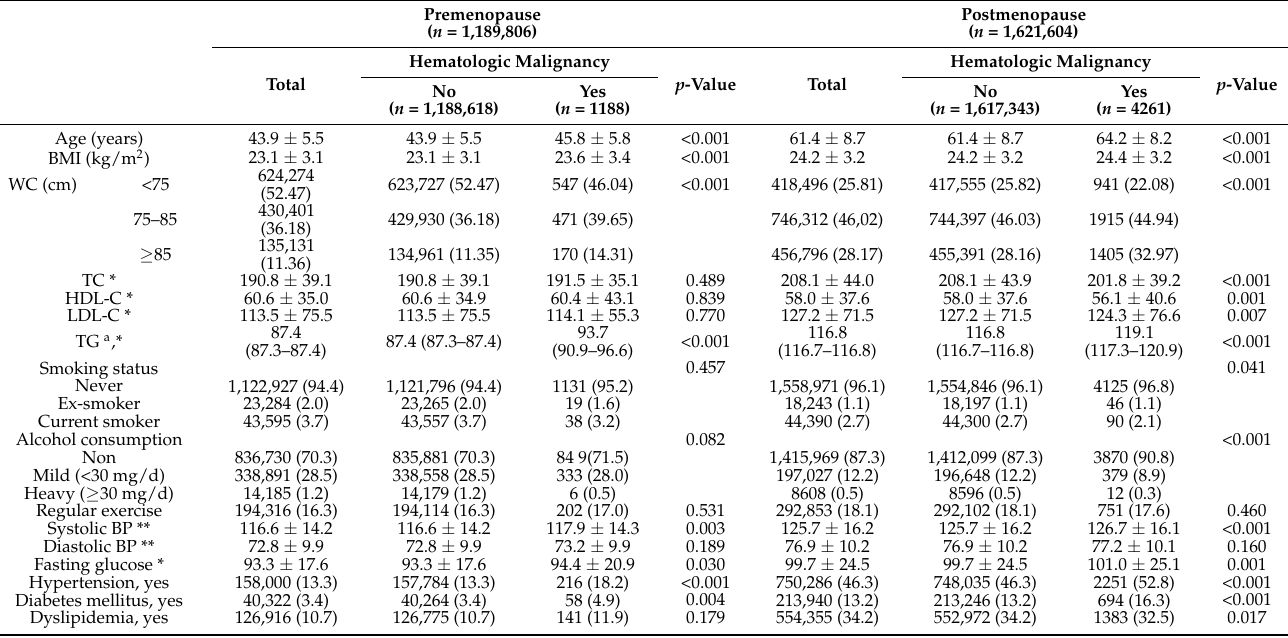
Table 1. Baseline characteristics of the study